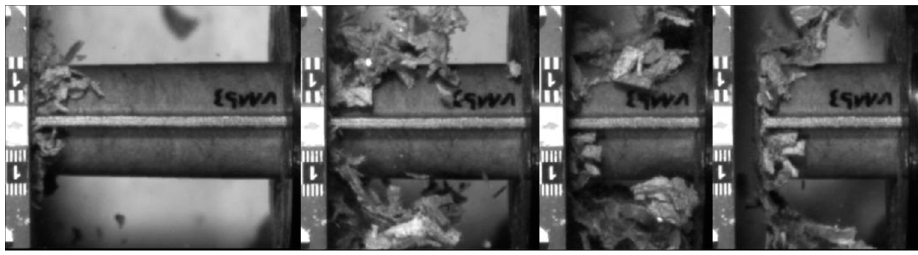
Figure 16. Transverse shear fracture failure mechanism for V11_b and c series experienced during the crash test.